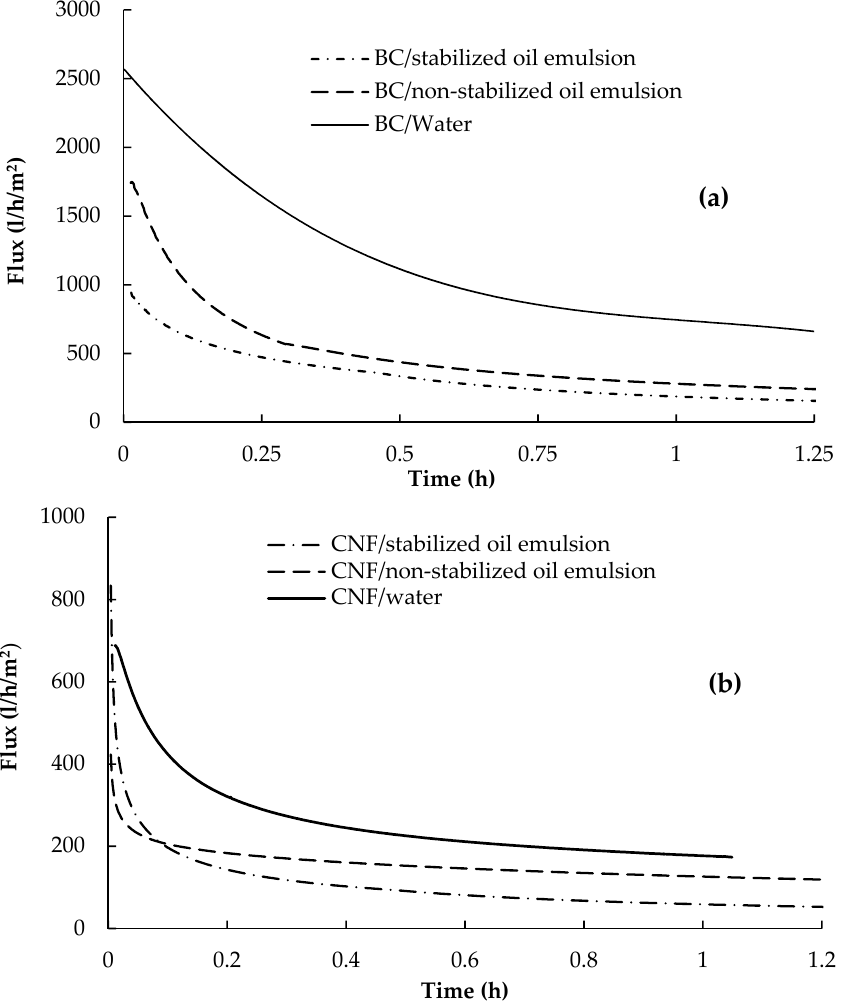
Figure 9. Flux curves of ( a ) bacterial cellulose and ( b ) CNF membranes for filtering stabilized and non-stabilized oil emulsions.